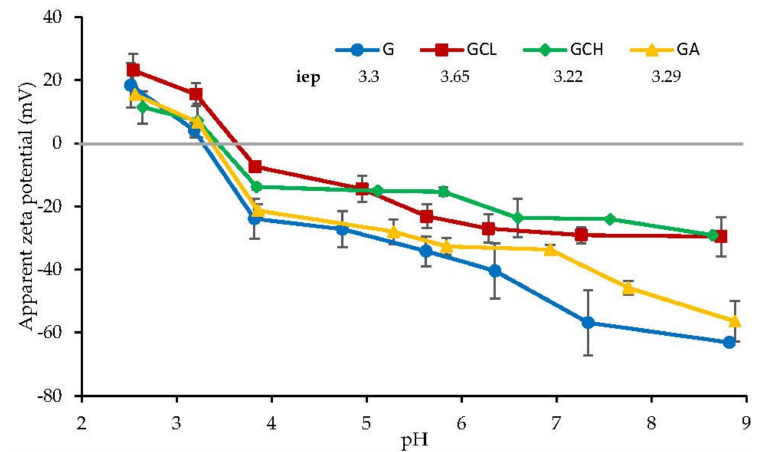
Figure 5. Zeta potential vs. pH profiles of the scaffolds (mean values ± sd; n = 3). In the inset, the isoelectric point (iep) is reported.